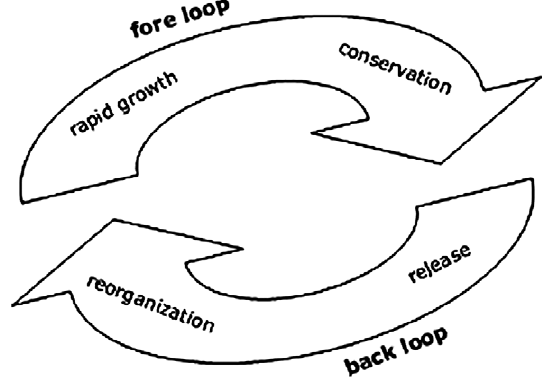
Figure 1. Simple representation of the adaptive cycle (after Walker and Salt